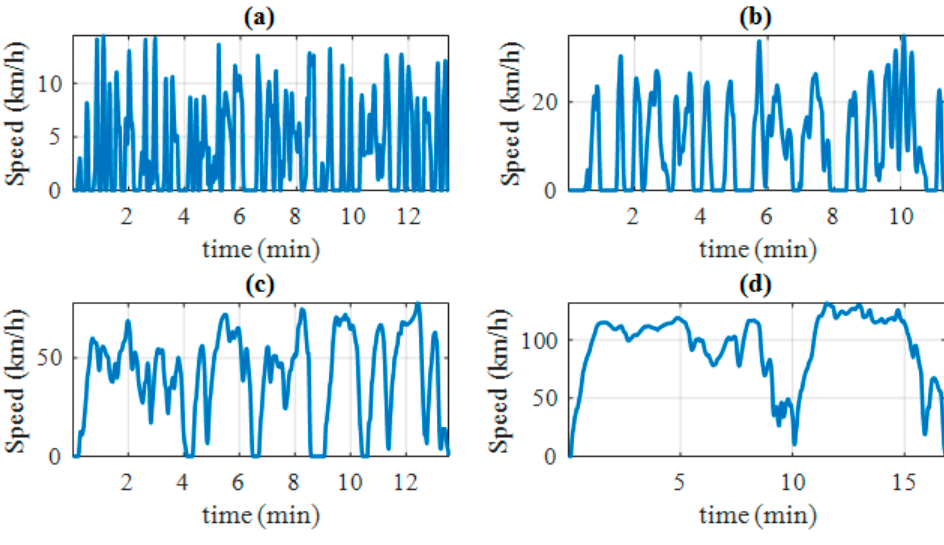
Table 1. Characteristics of the UL1, UF1, R2 and A2 INRETS driving cycles.